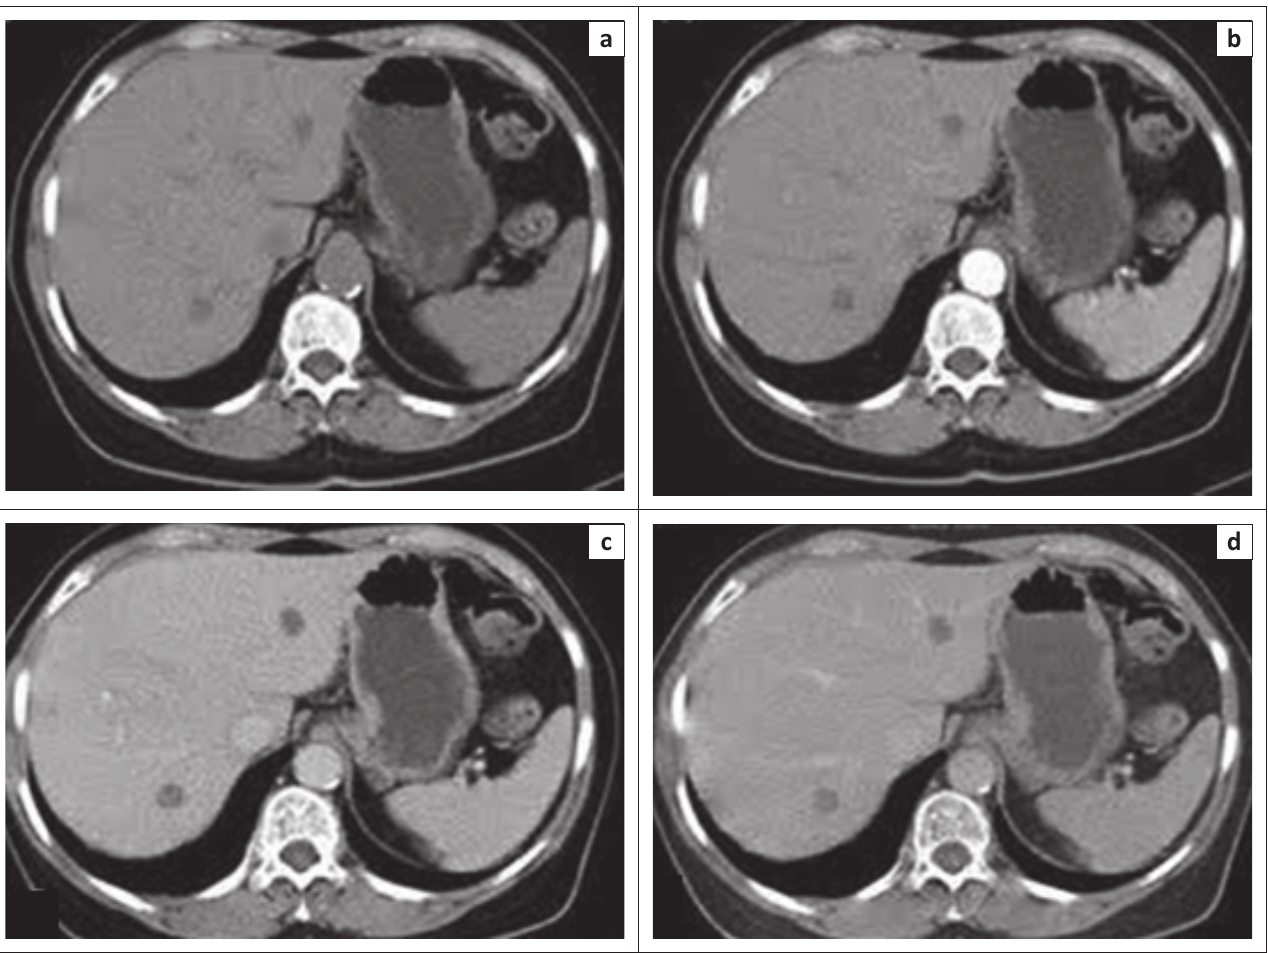
FIGURE 2: A 70-year-old man who presented with abdominal pain with no known primary malignancy. Axial computed tomography scan images of biopsy proven metastatic adenocarcinoma showing: (a) hypo-attenuation in the precontrast phase and no enhancement in (b) arterial, (c) portovenous and (d) delayed